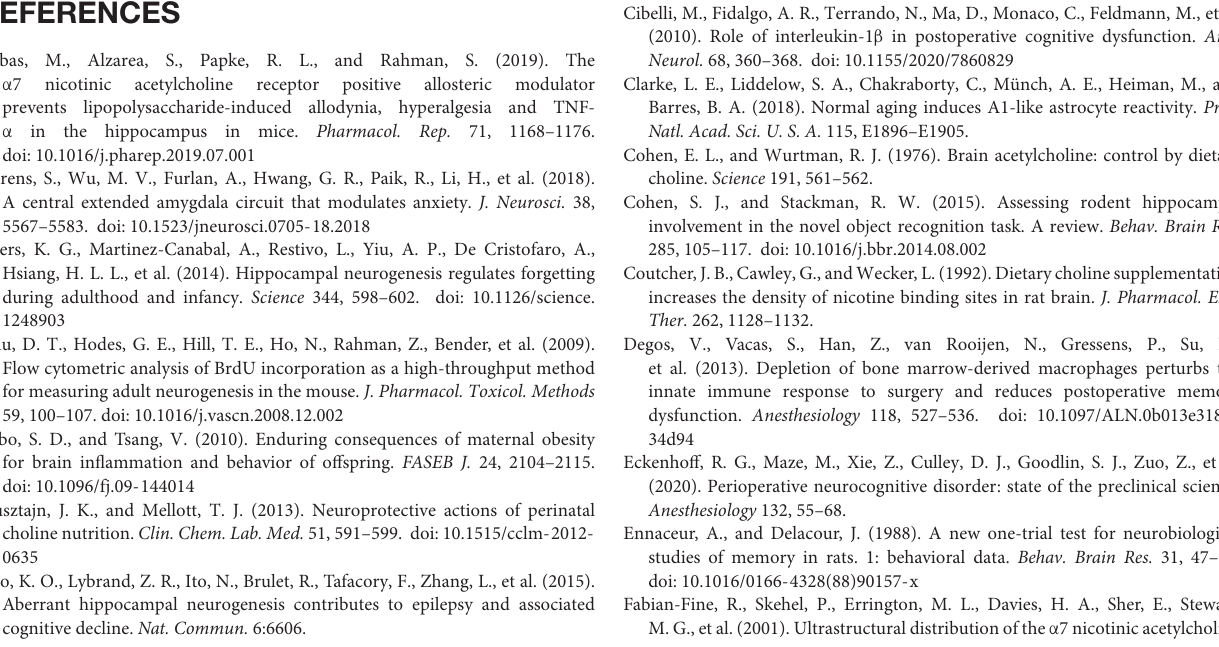
Supplementary Figure 1 | “Stitched” images of “tiles” indicating the counting area in the dentate gyrus of the hippocampus, presented as maximum intensity projections of the Z-stack. (A) Fluorescent micrograph of the dentate gyrus showing DCX+ staining. White box indicates an example of cells that would be quantified. (B) Fluorescent micrograph of the dentate gyrus showing GFAP staining. White outline indicates region of